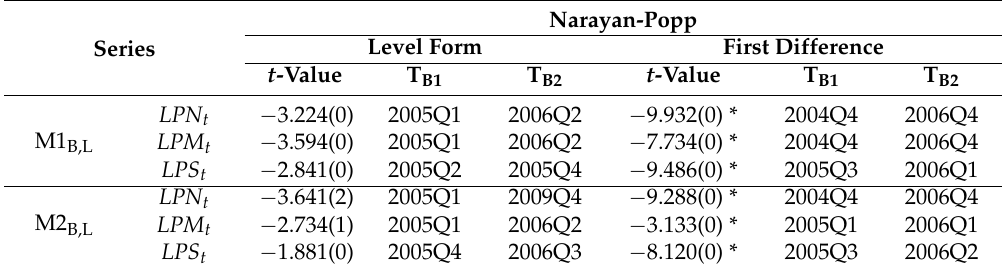
Table 6. Time-series unit root test with two